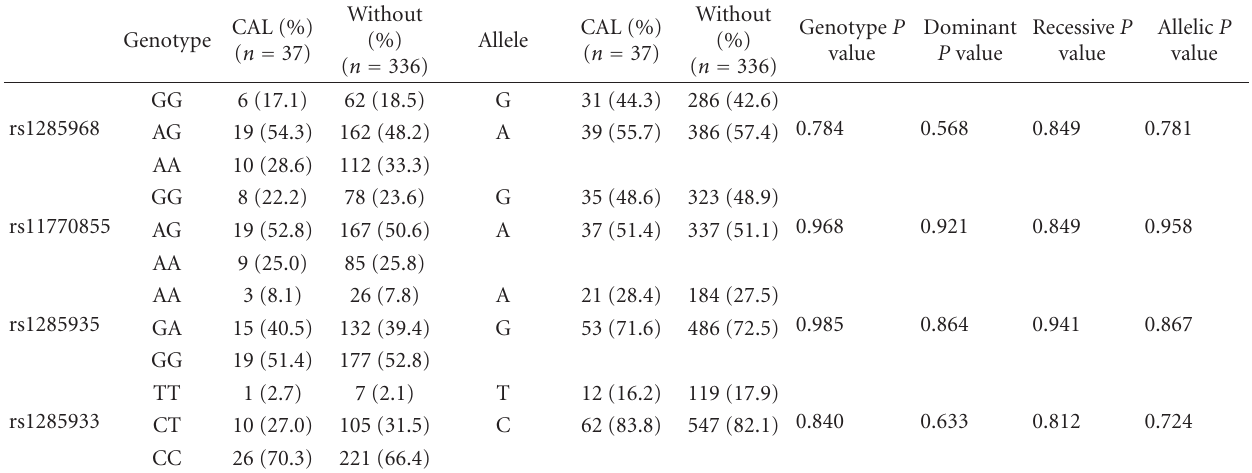
Table 3: Genotype and allele frequencies of the CLEC5A gene in patients with Kawasaki disease with or without coronary artery lesion formation